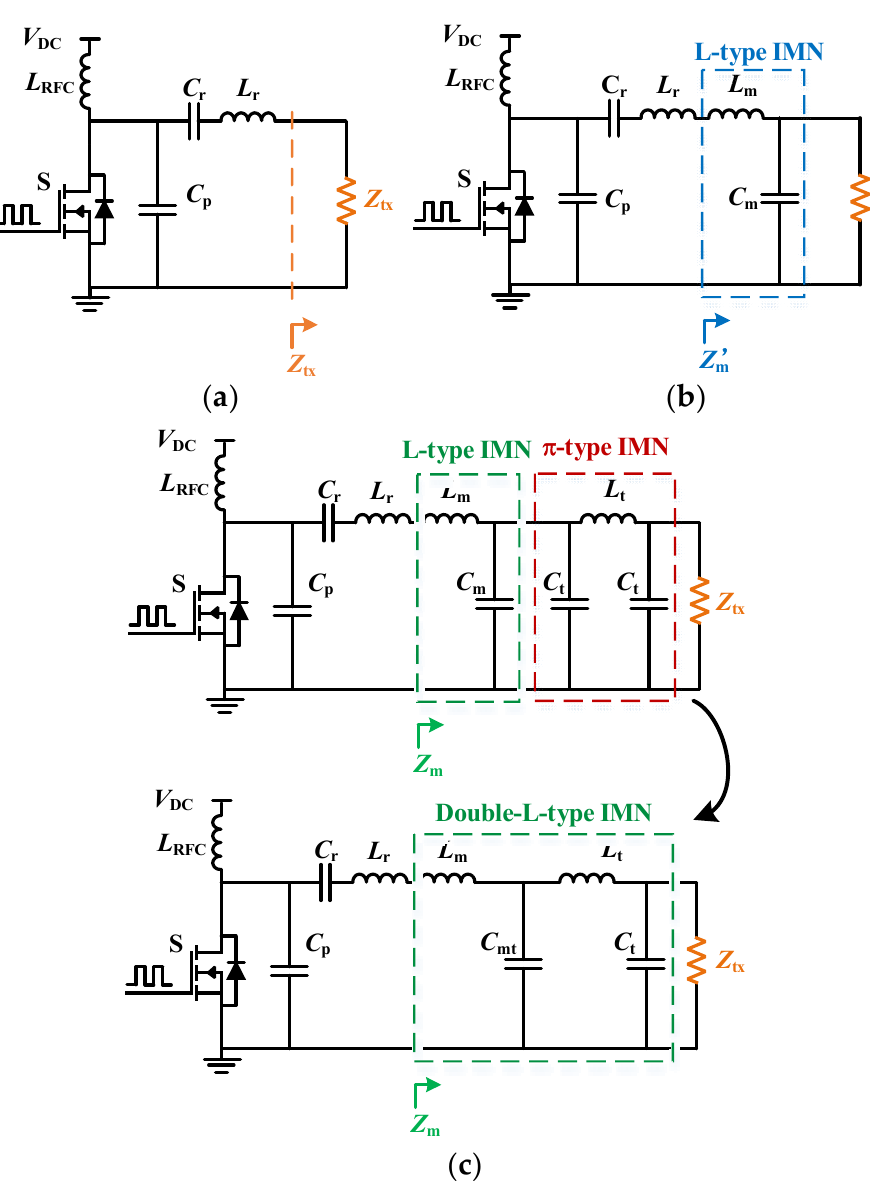
Figure 4. Class-E power amplifier circuit: ( a ) conventional Class-E PA; ( b ) Class-E PA with an L-type IMN; ( c ) Class-E PA with a double-L-type IMN.